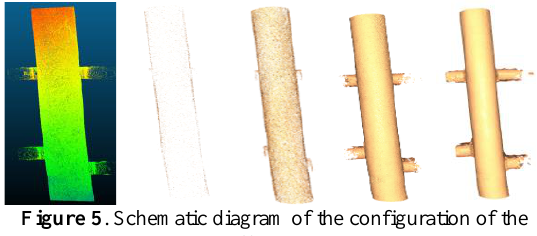
Figure 5 . Schematic diagram of the configuration of the network with different parameter